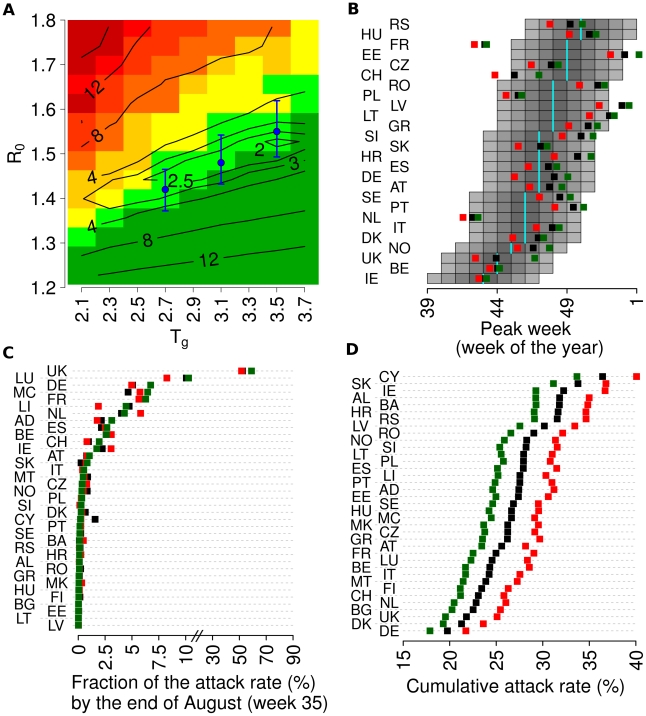
Sensitivity to assumed R
0 and T
g.(A) Sensitivity analysis by varying R0
UK and Tg: level curves (and numbers) in black represent the mean deviation between observed and predicted peek week (in weeks). Colours represent the expected number N of countries with peak of the summer wave above 30 per 1000 individuals, ranging from dark green (N = 0) to dark red (N>30). Light green indicates 0.5<N< = 1.5, yellow indicates 1.5<N< = 2.5 and light orange indicate 2.5<N< = 5. Blue points represent possible pairs (R0
UK, Tg) as resulting from the Qsurveillance data: R0
UK = 1.42, Tg = 2.7 days; R0
UK = 1.48, Tg = 3.1 days; R0
UK = 1.55, Tg = 3.5 days. Blue vertical lines represent the uncertainty of R0
UK as resulting from the uncertainty of the growth rate r of the Qsurveillance data. (B) Peak week for European countries covered by the WHO/Europe weekly influenza surveillance system as observed (cyan bars), as predicted by simulations with R0
UK = 1.48 and Tg = 3.1 days (black squares), as predicted by simulations with R0
UK = 1.42 and Tg = 2.7 days (green squares) and as predicted by simulations with R0
UK = 1.55 and Tg = 3.5 days (red squares). (C) As (B) but for the fraction of the attack rate by end of August. (D) As (B) but for the cumulative attack rate. A total of 100 simulations were undertaken for each parameter set to produce the results shown.